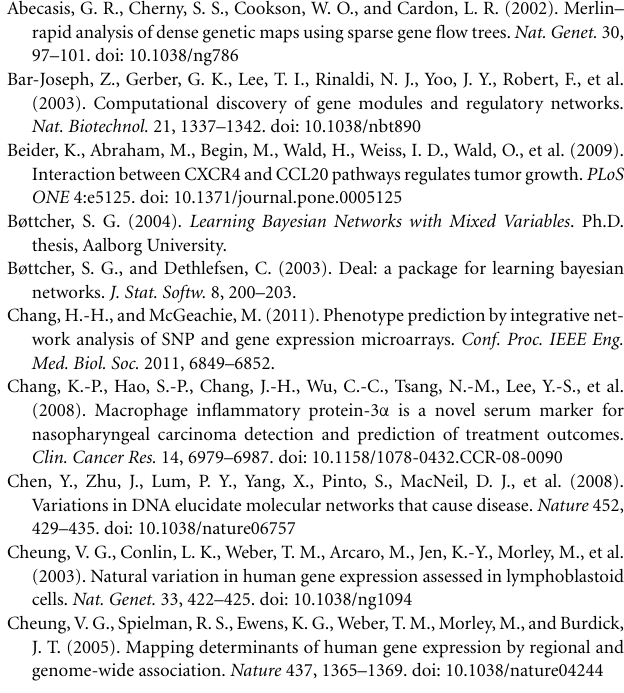
nPARS would have a diminished power to detect such